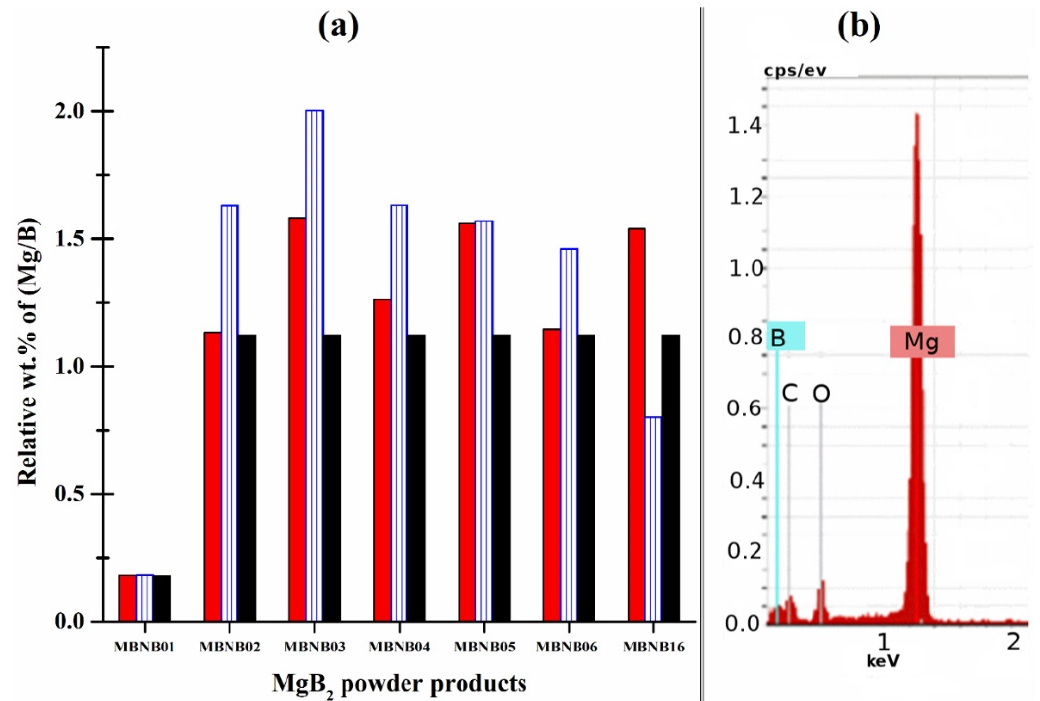
Figure 4. ( a ) Mg:B elemental ratio for the different samples expressed in terms of wt. %, as obtained from different analysis/calculation methods. Red and blue bars are calculated from XRD and EDX data, respectively. Black bars represent the expected values for a pure MgB 2 (or Mg 2 B 25 , in case of sample MBNB01) stoichiometry; ( b ) EDX spectrum of a representative sample (MBNB06) with indications of the elemental peaks detected.